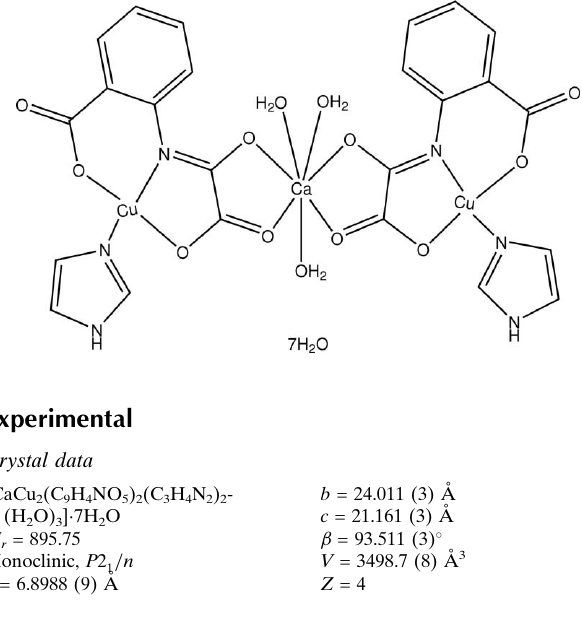
For related literature, see: Zang et al. (2003).